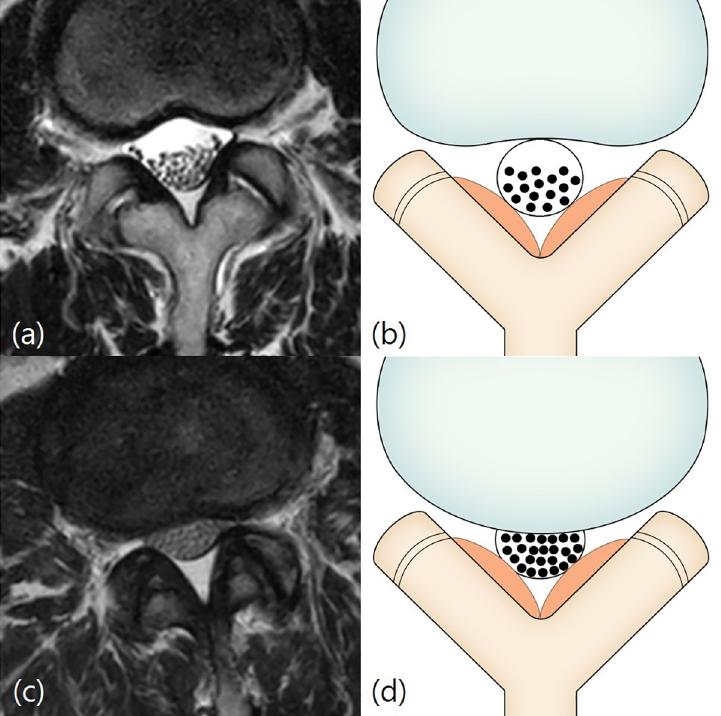
Fig 4. Lee classification. Grade 0 and 1 (no or mild stenosis). Figs 4A and 3B: Grade 0 (no stenosis). A 66-year-old woman with lower back pain. T2-weighted axial magnetic resonance image at L2/3 disc level shows no obliteration of the anterior cerebrospinal fluid space. Fig 4C and 4D: Grade 1 (mild stenosis). A 61-year-old woman with lower back pain. T2-weighted axial magnetic resonance image at L2/3 disc level shows mild obliteration of the anterior cerebrospinal fluid space and all cauda equina clearly separated from each other.